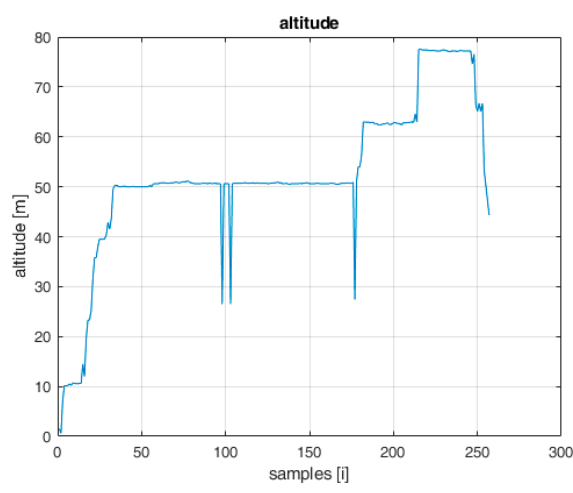
Figure 3. UAV flight altitude broadcasted by AeroScope.